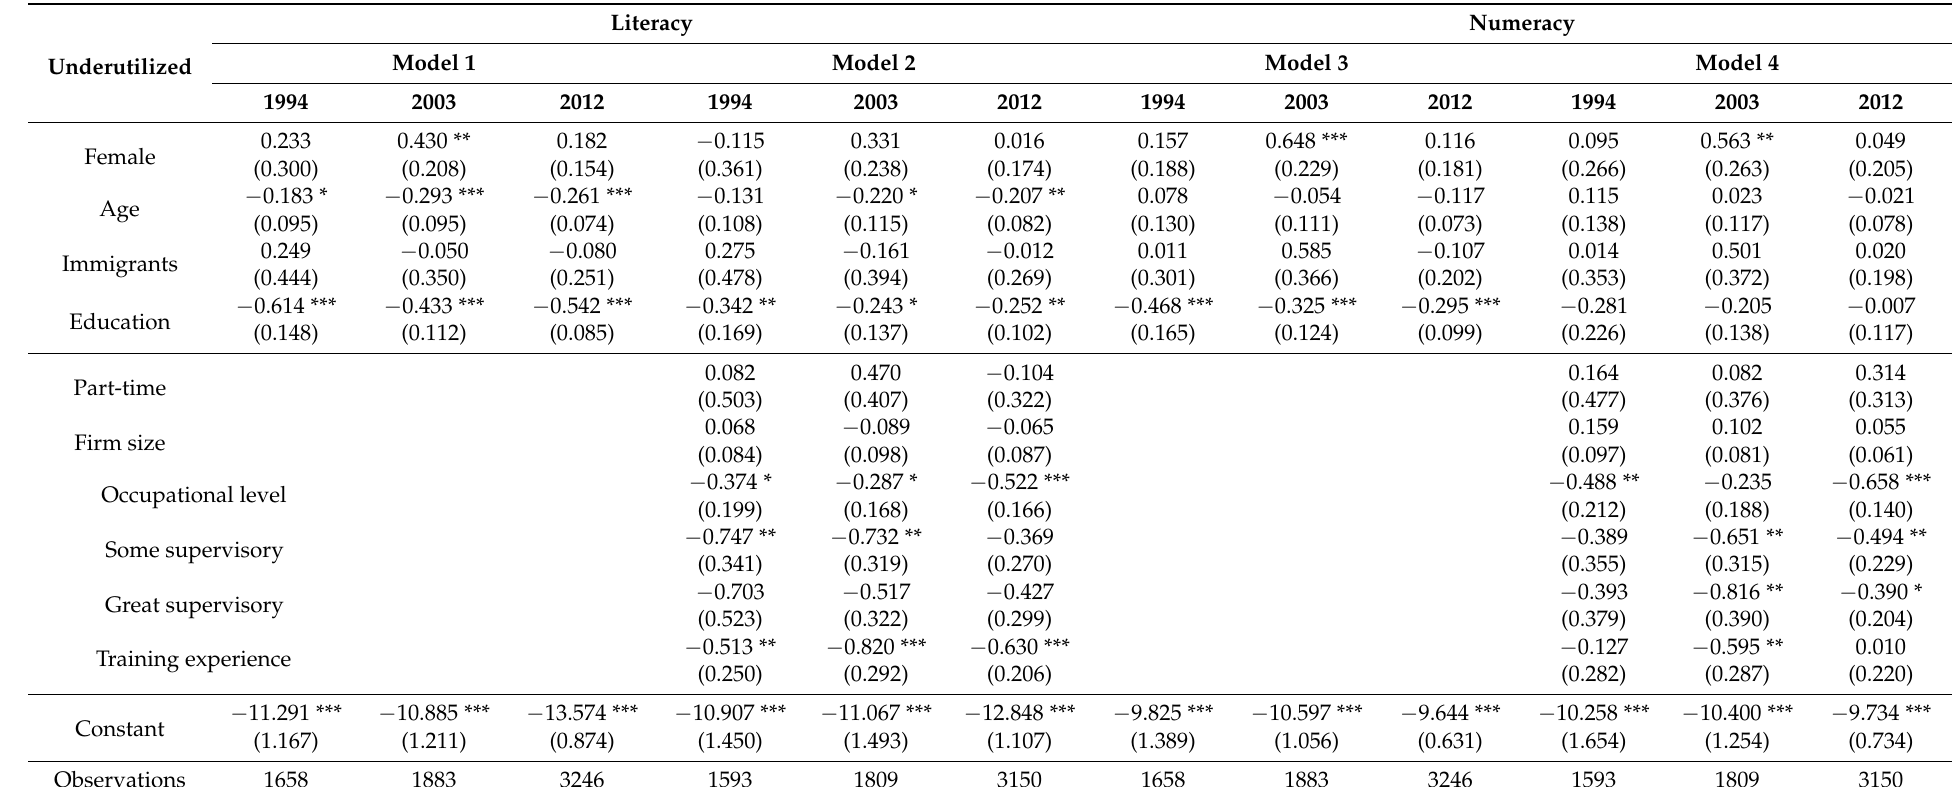
Table 6. Literacy and numeracy skill mismatch: underutilized vs.